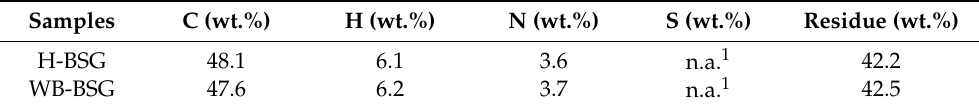
Table 1. Elemental analysis of Helles brewers’ spent grain (H-BSG, top) and wheat beer-BSG (WB- BSG, bottom).